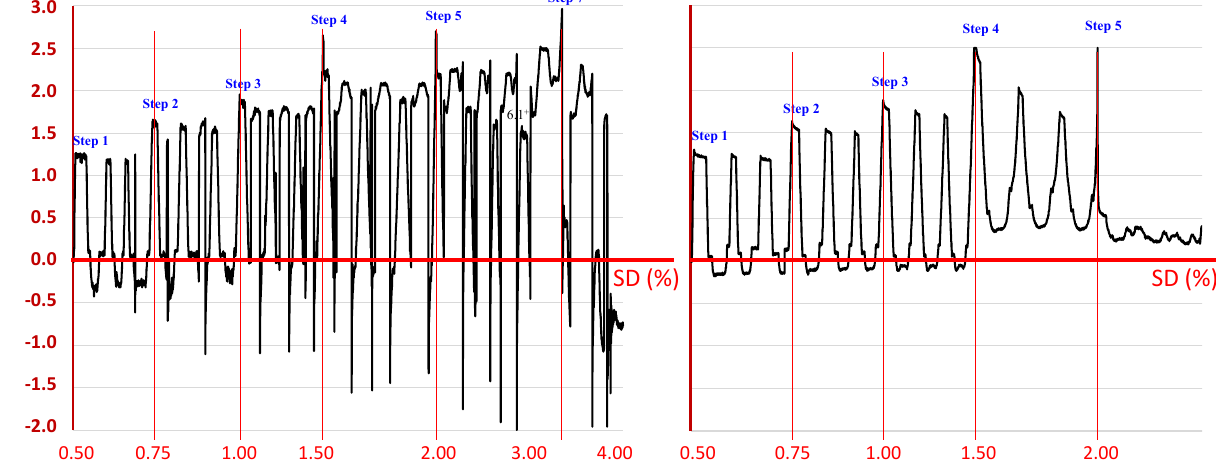
Figure 12. Comparative presentation of the strain history of a column longitudinal steel bar during the testing procedure of the two specimens (JC0 and JB0F), as recorded by strain gauges epoxy-bonded on the steel bars of each specimen.